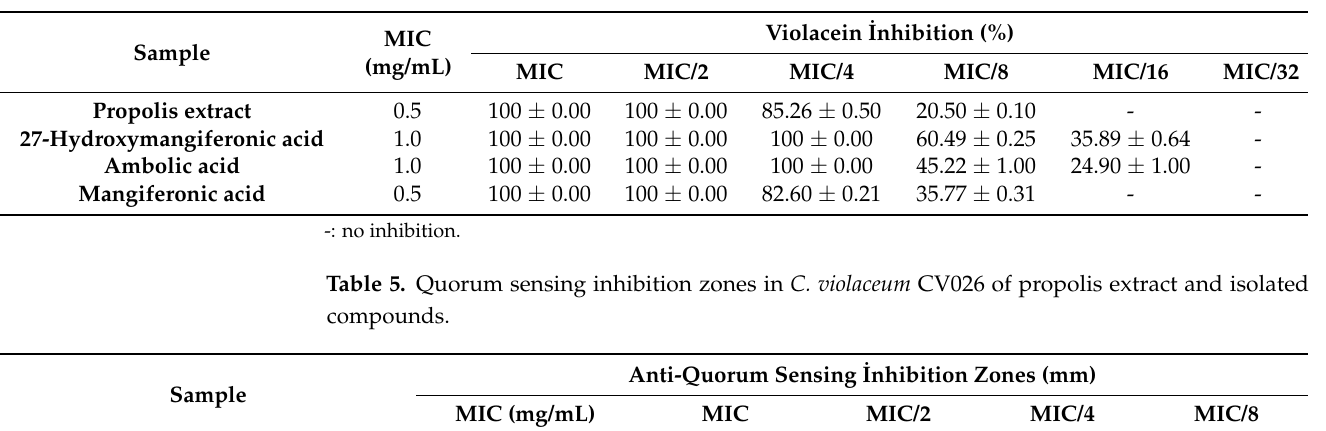
Table 4. Inhibition of violacein production in C. violaceum CV12472 of propolis extract and isolated compounds.